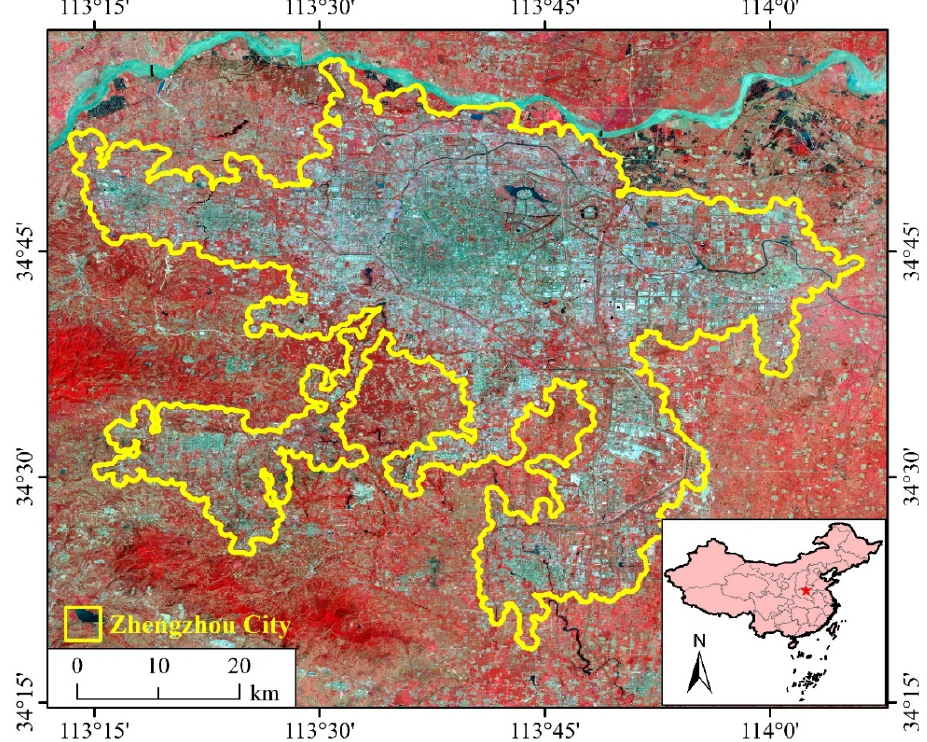
Figure 1. Geographic location of the study area. The remote ‐ sensing imagery in the graphic was from the data composite of Landsat 8 OLI in Zhengzhou City during June ‐ August in 2020.